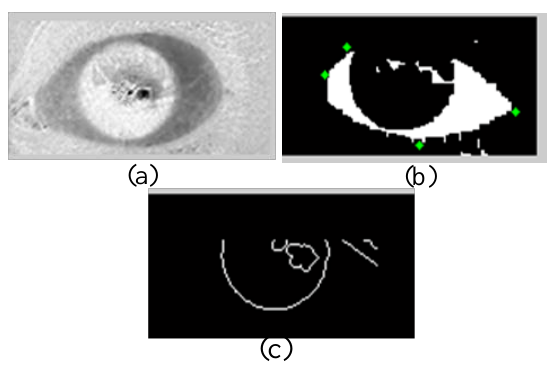
Figure 4. (a) eye image saturation, (b) thresholding result (by process described in figure 2), (c) result of applying logical AND operator applied to iris boundary image and sclera image.